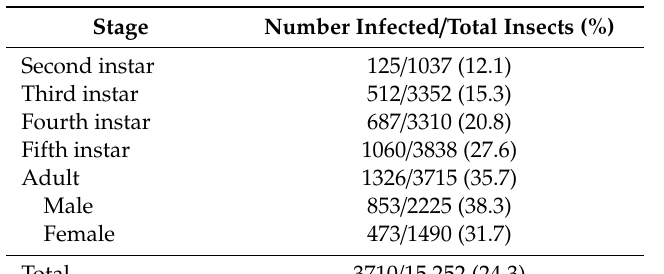
Table 1. Trypanosoma cruzi infection status by developmental stage, for 15,252 triatomines captured in 188 infected colonies in Arequipa, Peru.